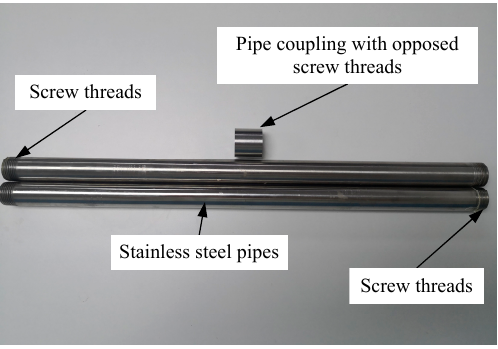
Figure 9. Stainless-steel detection tubes and their coupling mechanism.